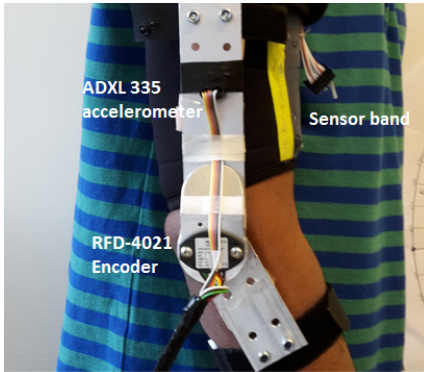
Figure 3: An instrumented passive arm exoskeleton to collect the data for SVM